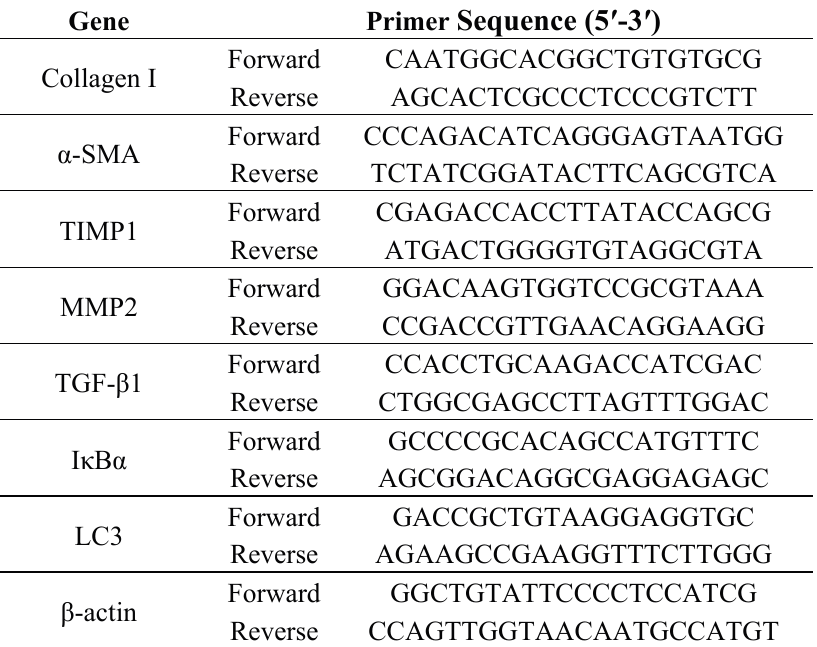
Table 1. Nucleotide sequences of primers used for PCR. Gene Primer Sequence (5 ′ -3 ′